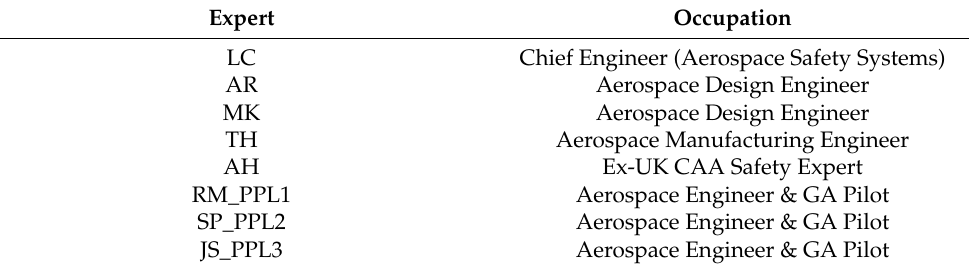
Table 3. Summary of